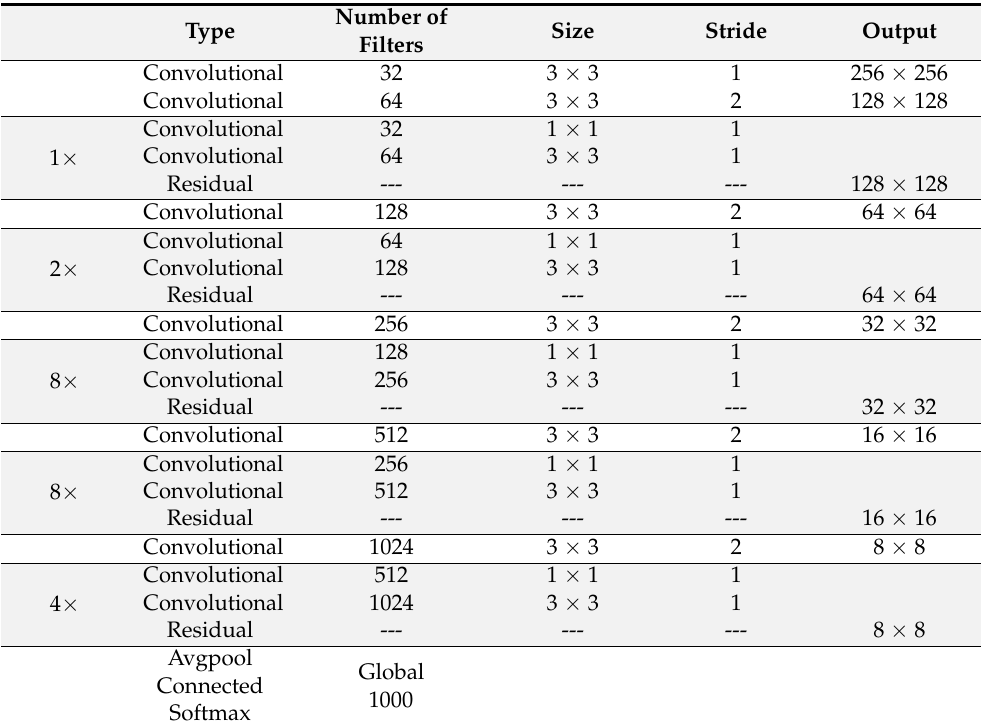
Figure 3. YOLOv3 algorithm outline. Table 1. Darknet-53 network structure.